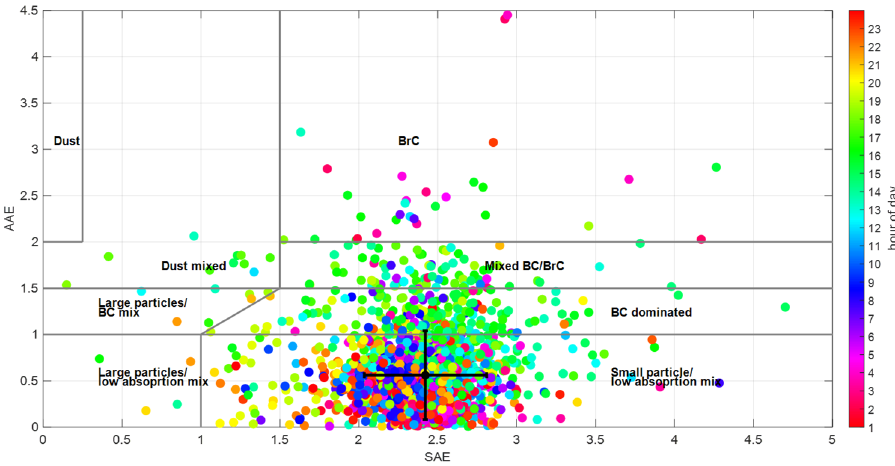
Figure 3. Scatter plot of SAE and AAE. Particle colors represent the hour of the day.